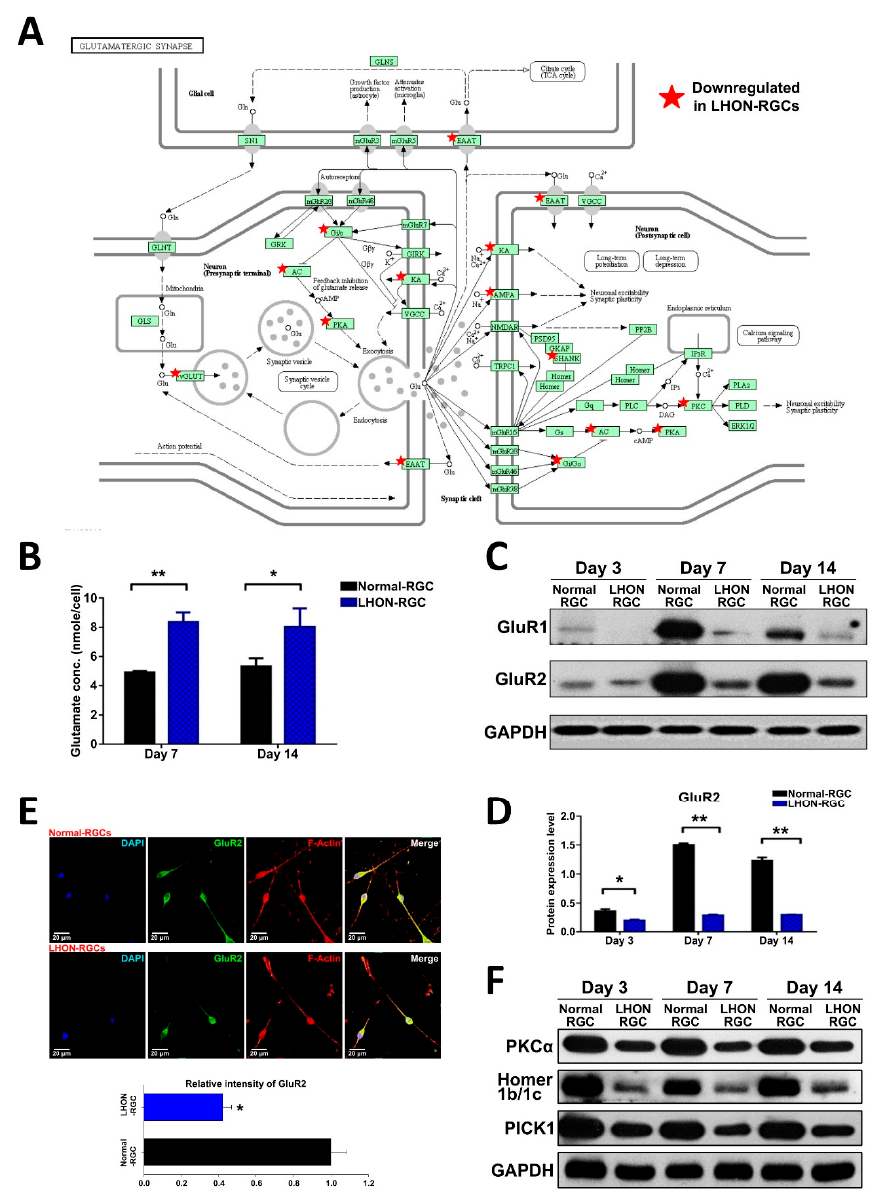
Figure 4. α -amino-3-hydroxy-5-methylisoxazole-4-propionic acid (AMPA) receptors and AMPA scaffold proteins are downregulated in LHON-RGCs. ( A ) Schematic showing KEGG pathway “Glutamatergic synapse” with the genes downregulated in LHON-RGCs marked with asterisks. ( B ) ELISA measurement of glutamate secreted by 7-day and 14-day Normal-RGCs and Control-RGCs. Mean concentrations from three independent measurements are shown with standard deviation error bars. ( C ) Western blot analysis demonstrating expression of GluR1 and GluR2 in day-3, day-7 and day-14 Normal-RGCs and LHON-RGCs. GAPDH used as a loading control. ( D ) Quantification of Western blot expression levels of GluR1 and GluR2. Means from three independent experiments are shown with standard deviation error bars. ** p < 0.01, * p < 0.05. ( E ) Immunofluorescent staining of GluR2 in Normal-RGCs and LHON-RGCs. Signal intensity was quantified by ImageJ and shown below. Nuclei stained with DAPI, neurites–by immunostaining of F-actin. ( F ) Western blot analysis of expression of AMPA receptor-associated sca ff old proteins in Normal-RGCs and LHON-RGCs at di ff erent stages of maturity. GAPDH used as a loading